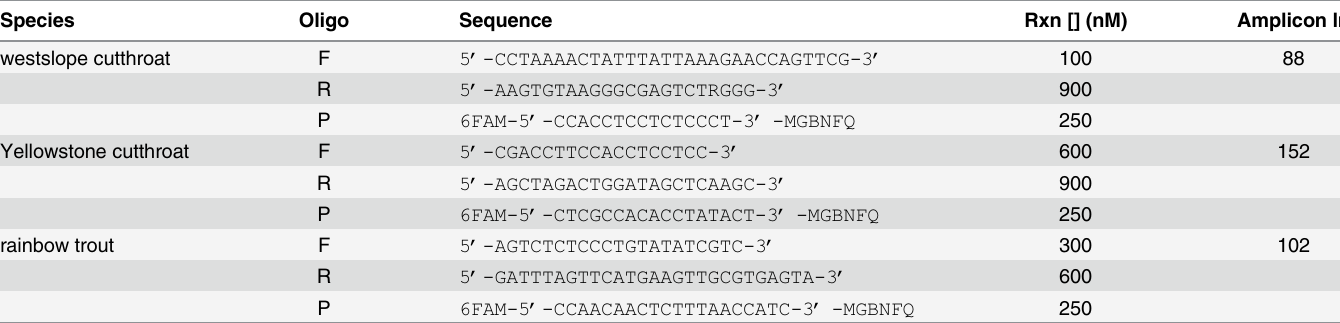
Table 2. Sequences for each of the validated taxon-specific qPCR assays.